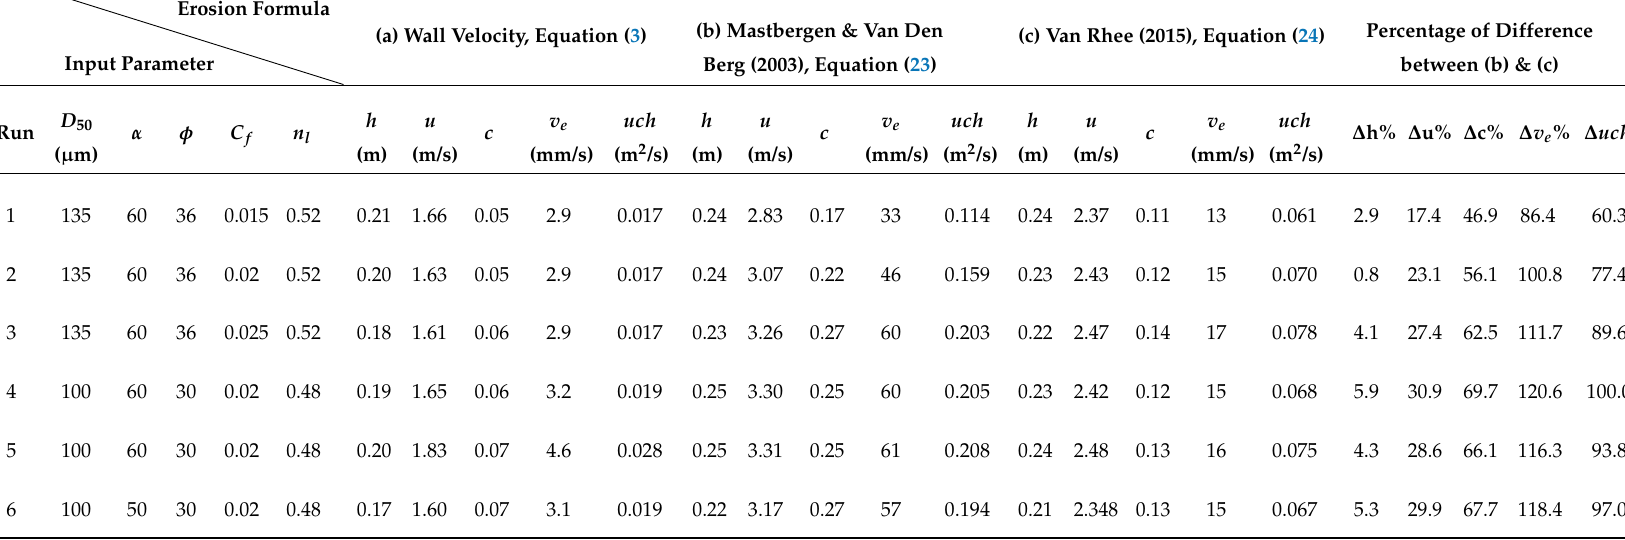
Table 2. Values of v e , u , c , h , and uch computed 10 m downstream from the origin, using the three different erosion